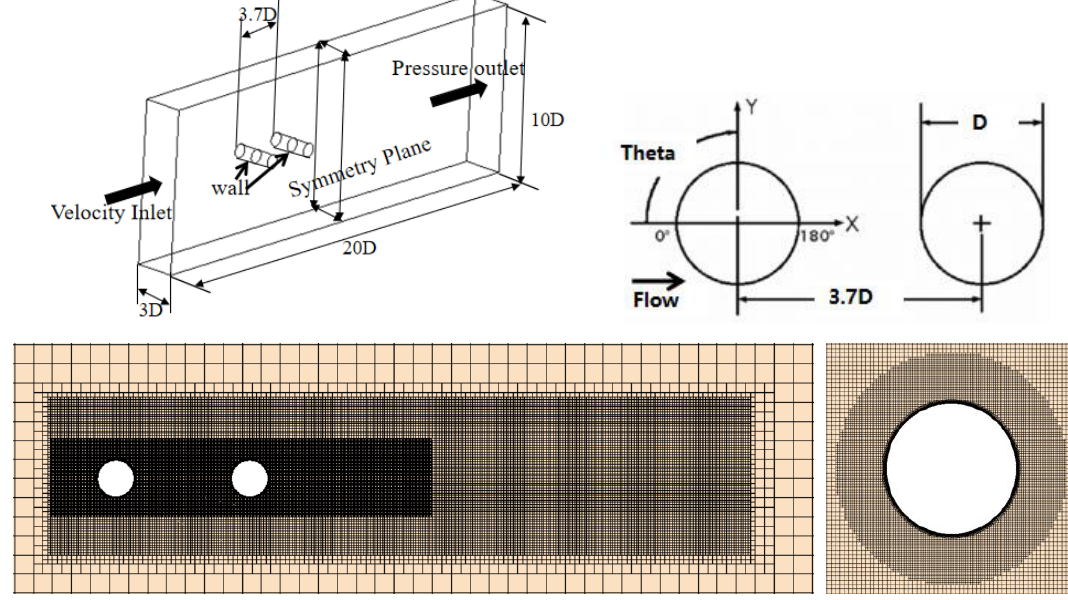
Figure 11. Geometry and computational domain for flow field of two cylinders in tandem.